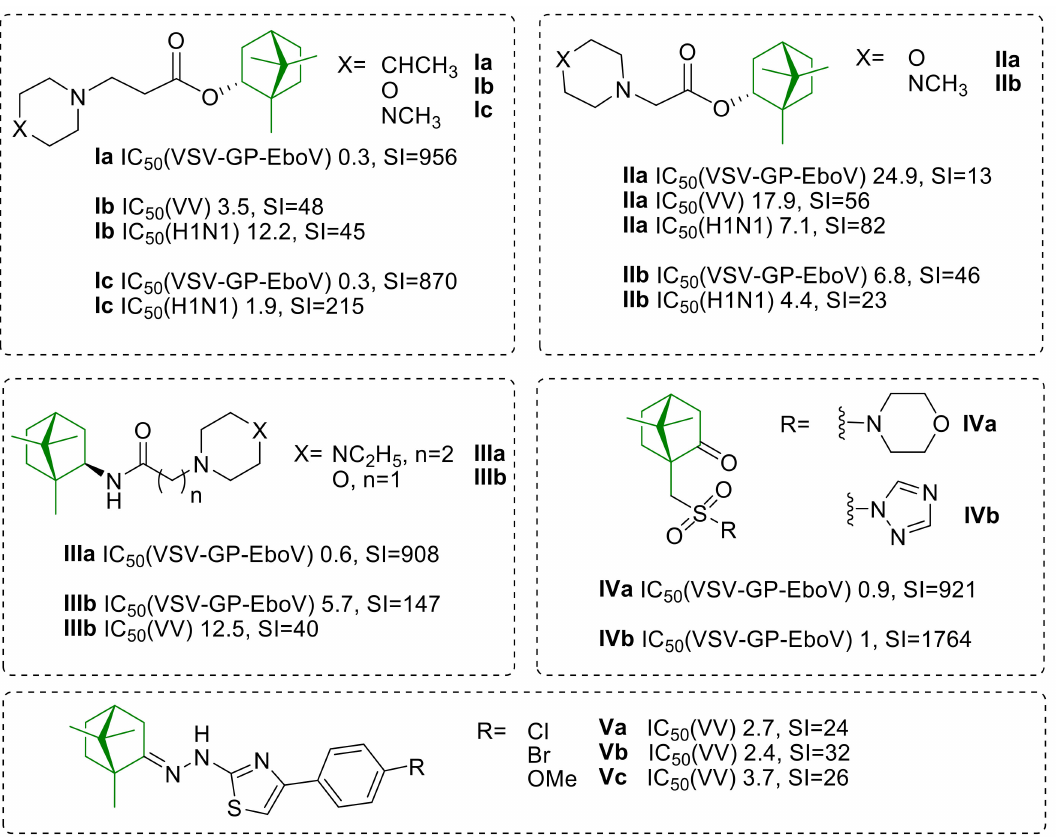
Figure 1. Compounds with 1,7,7-trimethylbicyclo[2.2.1]heptane backbone and their antivi- ral properties. All IC 50 values are given in µ M. Anti-influenza activity is described in [16], anti-orthopoxvirus—[14,17], anti-filovirus—[10–12]. The structure of previously identified leader compounds contains both a bicyclic bornane skeleton and a nitrogen-containing cyclic structural block. Thus, the design of the target molecules is promising, using a similar principle: a combination of a terpene block and a pharmacophoric heterocyclic core. In this work, the starting terpene compound is camphor, and 2,3-dihydrothiazoles and thiazolidinones are used as heterocyclic phar- macophores. Molecules constructed in this way have a high potential for the study of their antiviral properties and can become promising candidates for creating new medicinal agents on their